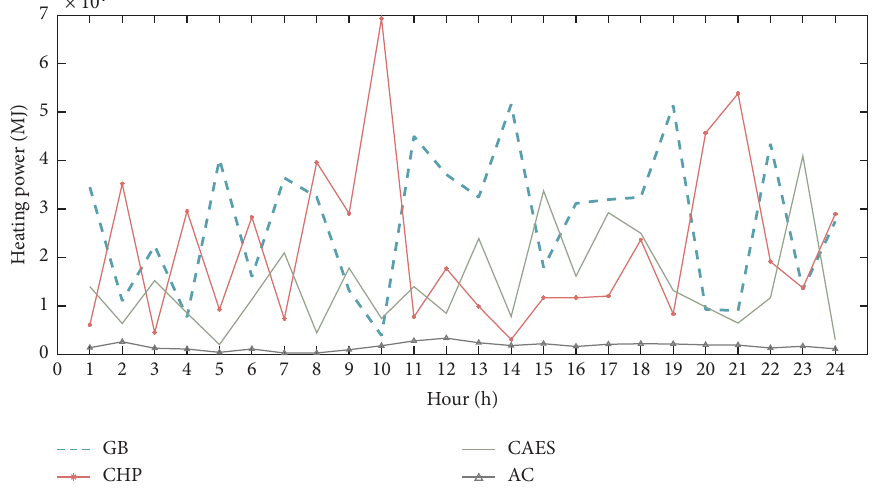
Figure 13: Heating energy dispatch in spring/autumn.